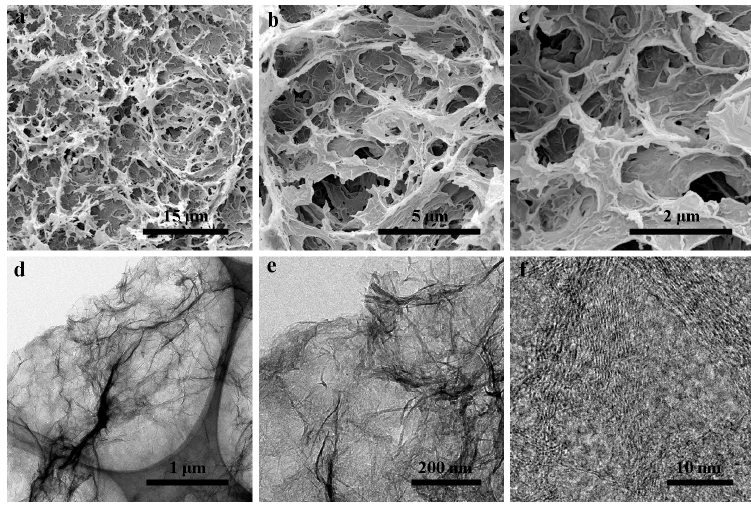
Figure 1. Different magnifications SEM ( a – c ) and TEM ( d – f ) images of GH morphology.